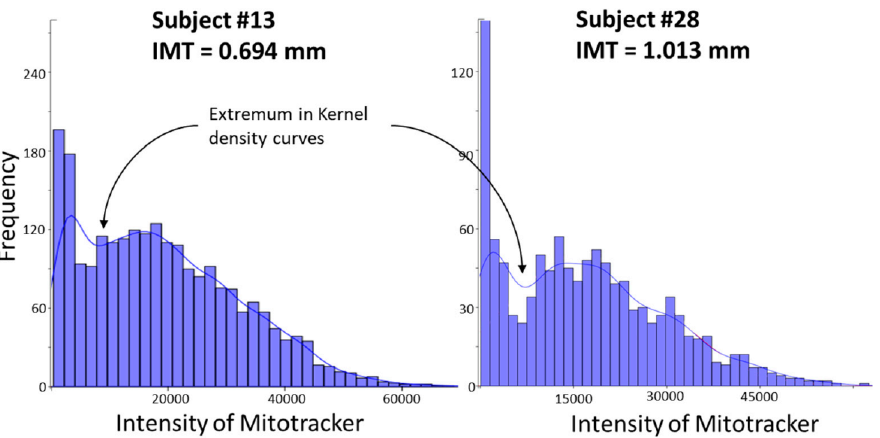
Figure 4. Bimodal distribution of the MitoTracker staining intensity of CD14+ human monocytes. Shown are the results for two study subjects with different intima-media thickness (IMT) values, corresponding to a normal (Subject 13) and an atherosclerotic (Subject 28) status. The extremum in the Kernel density curve used for the subsequent analysis of cell population on each histogram is shown with arrows.